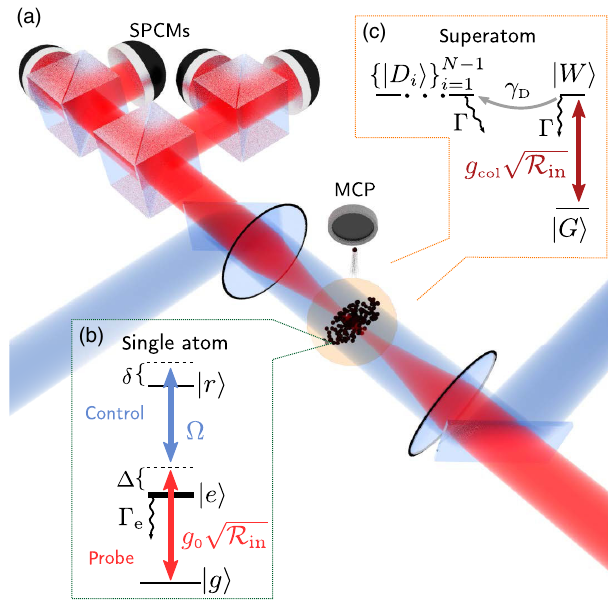
FIG. 1. Experimental setup and level scheme. (a) An ensemble of laser-cooled atoms is confined within a blockade volume using an optical dipole trap. Single-photon counting modules (SPCMs) are used to detect the light that interacts with the atoms, while a multichannel plate (MCP) detects the Rydberg atoms after ionization. (b) A few-photon probe field (red) and a strong control field (blue) couple the single-atom ground state j g i to a ffiffiffiffiffiffiffi p R Rydberg state j r i . Their respective Rabi frequencies are g 0 in and Ω , where g 0 is the single-atom coupling constant for the probe field and R is the photon rate. (c) Because of the Rydberg in blockade, the whole ensemble collectively behaves like a two- level system with many-body states j G i and j W i , including a loss N − 1 channel to a set of collective dark states fj D i ig i ¼ 1